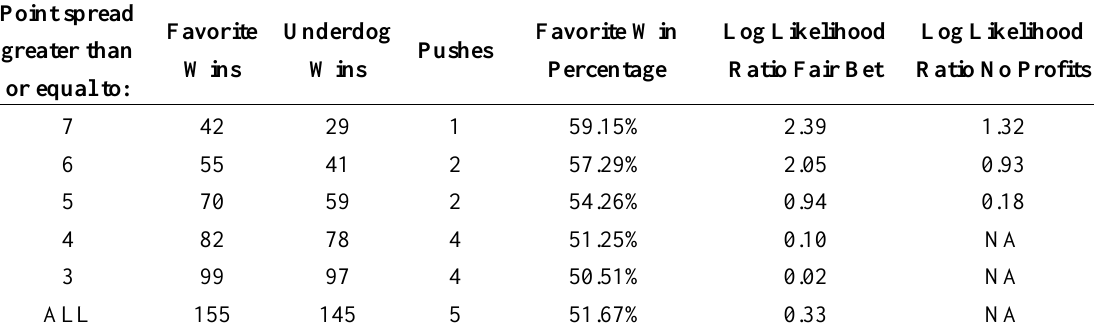
Table 4. Betting Simulation Results—WNBA—Road